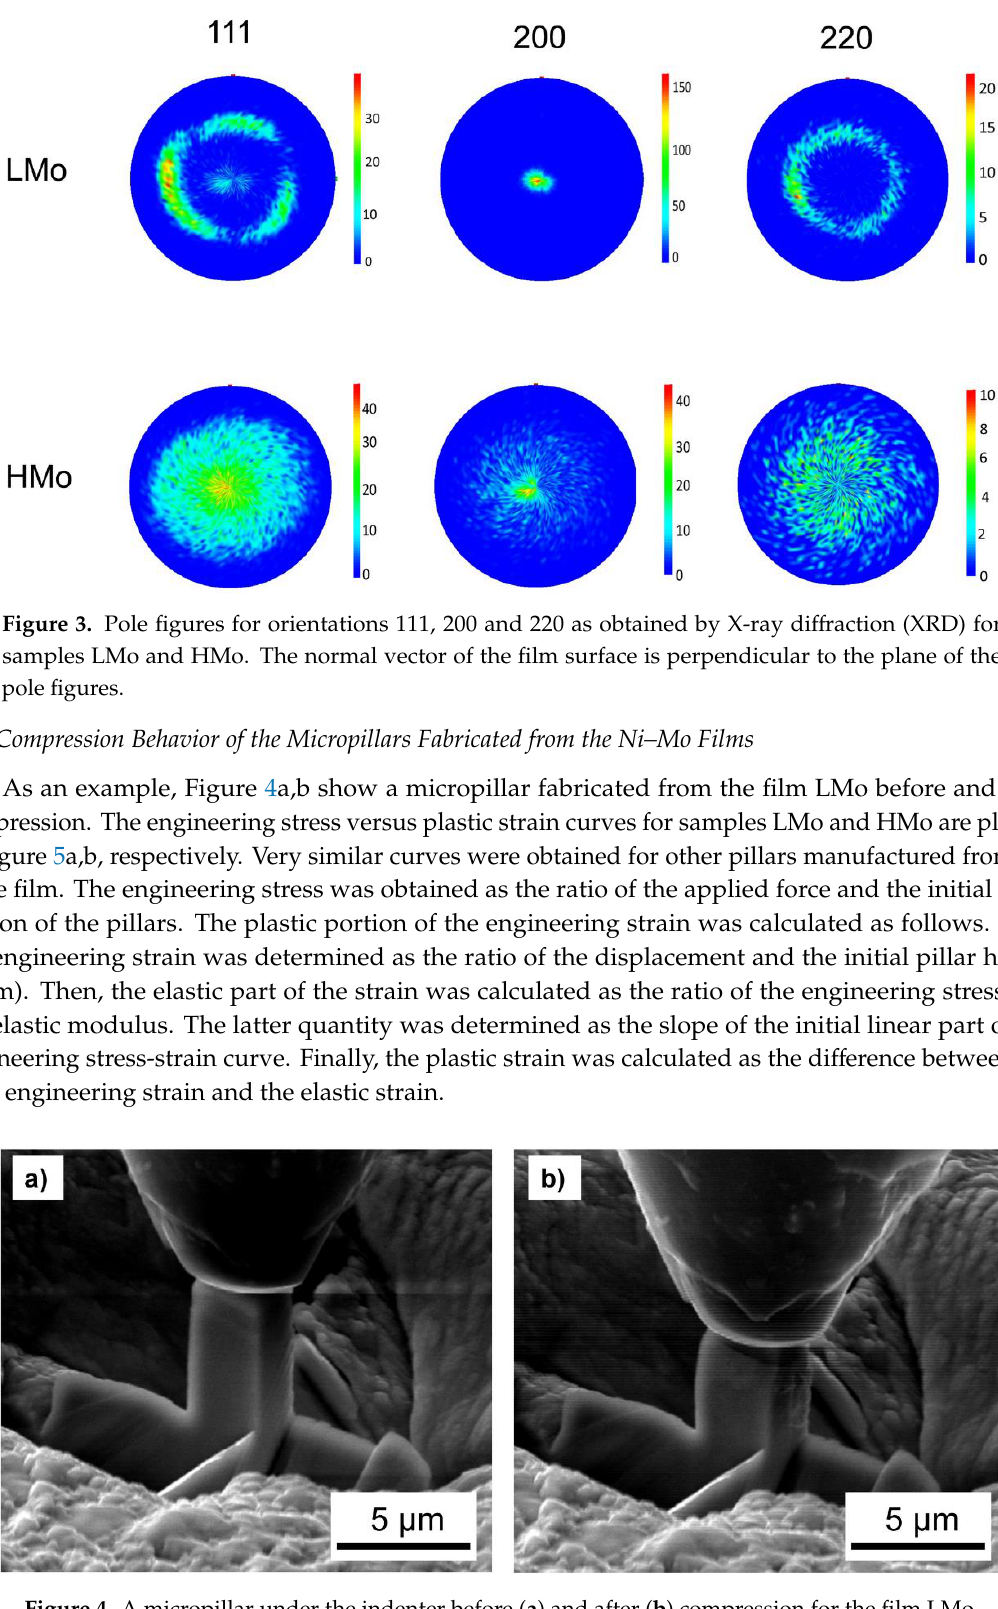
Figure 4. A micropillar under the indenter before ( a ) and after ( b ) compression for the film LMo.